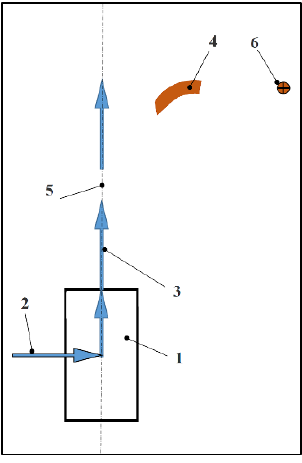
Figure 20. Switchgear diagram – variant No. 3.